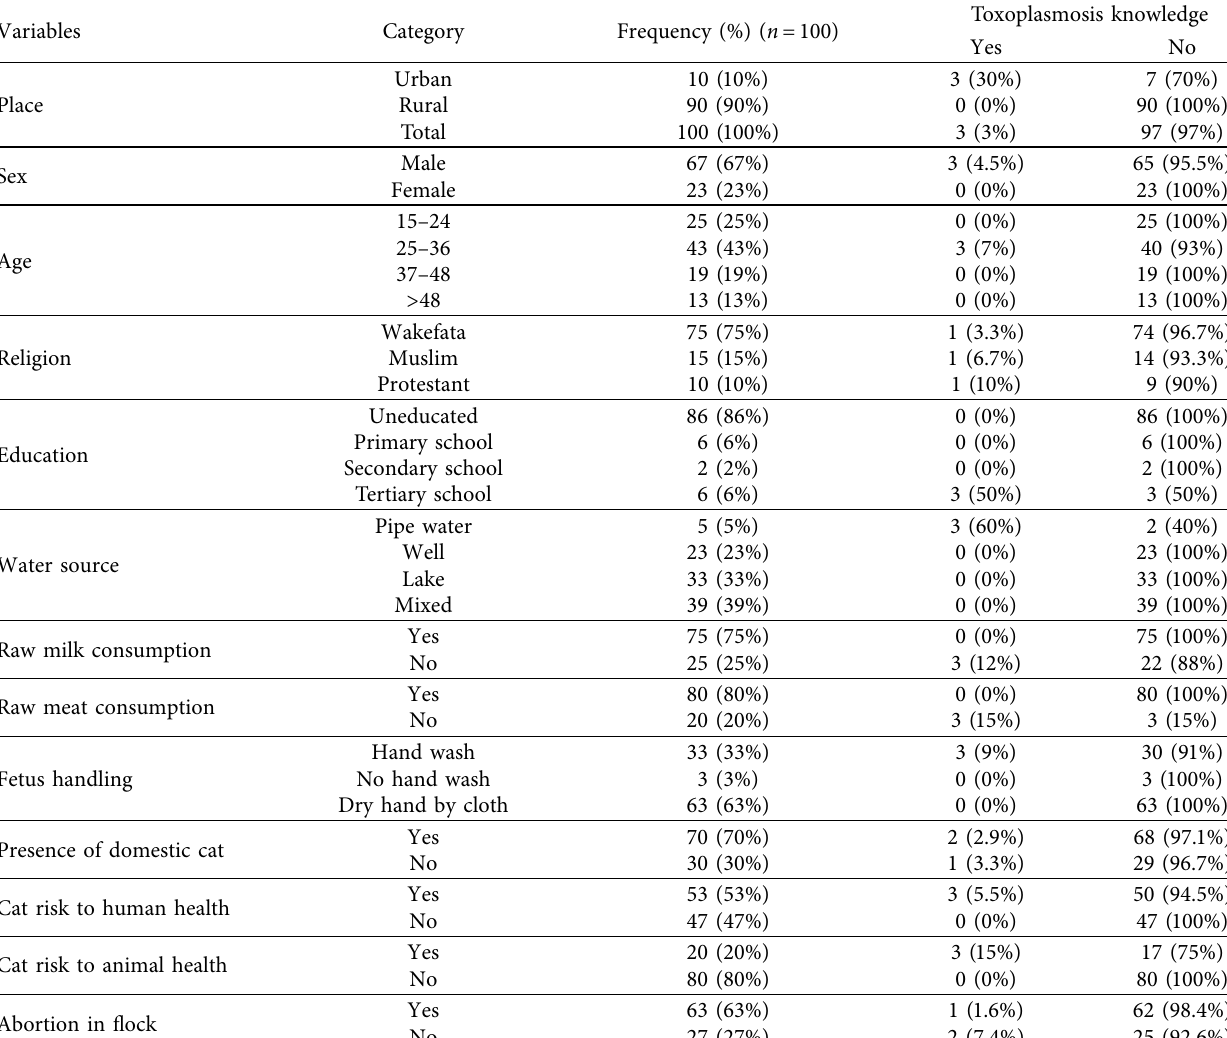
Table 5: Summary of the findings of the questionnaire survey regarding possible risk factors and awareness level of the community about toxoplasmosis in the Yabello